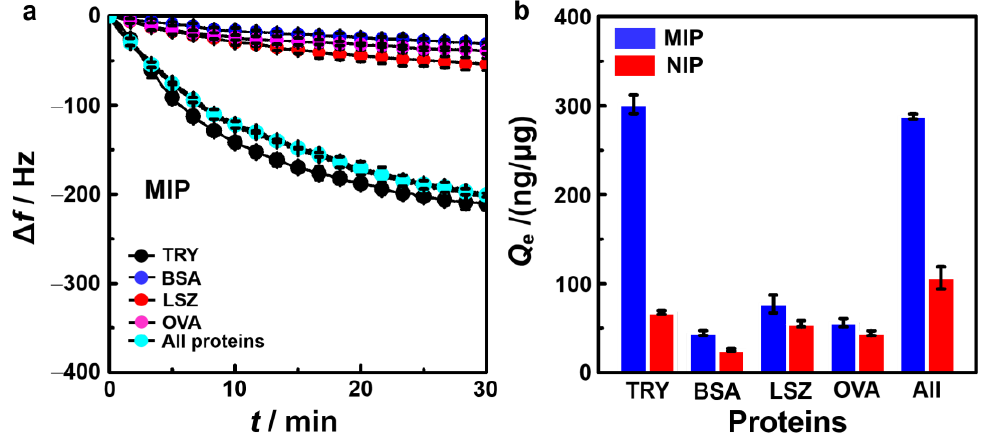
Figure 4. ( a ) ∆ f as a function of time during the adsorption of TRY and interfering proteins. ( b ) Q e values of MIP/NIP film-coated QCM sensors for different proteins (TRY, bovine serum albumin (BSA), lysozyme (LSZ), and ovalbumin (OVA)). All of the measurements were carried out in a 75 mL PBS (10 mM, pH = 7.4) solution containing 0.24 µ g/mL of individual proteins or all proteins (total concentration = 0.96 µ g/mL).